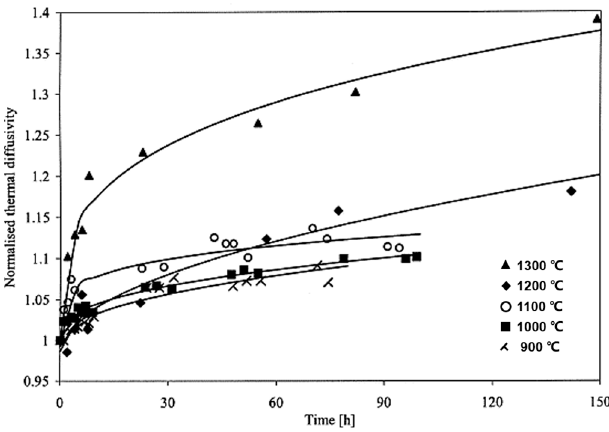
Figure 16. Normalized thermal diffusivity of TBCs at different temperatures as a function of thermal exposure time [96] .